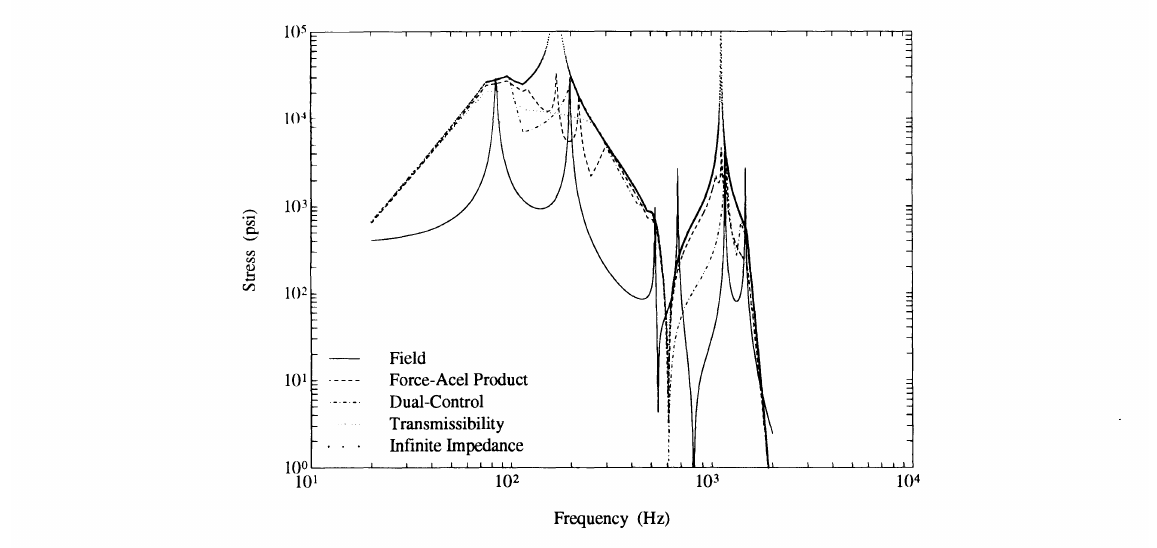
FIGURE 10 Transmissibility FRF of top block subsystem structure for use in transmissibility correc tion test